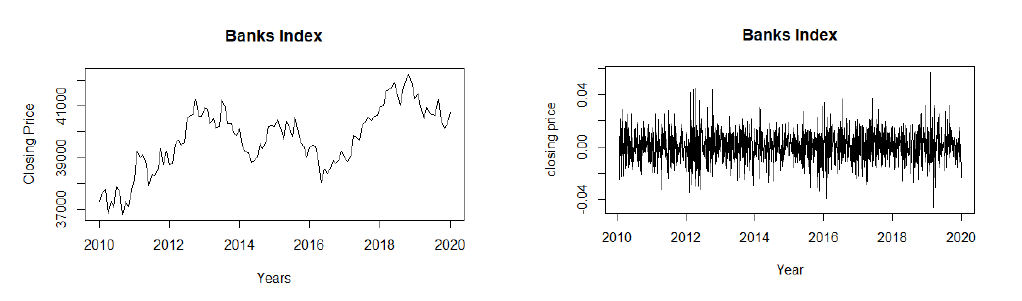
Figure 2. Time series plot of FTSE/JSE Banks Index prices (left) and one-day returns